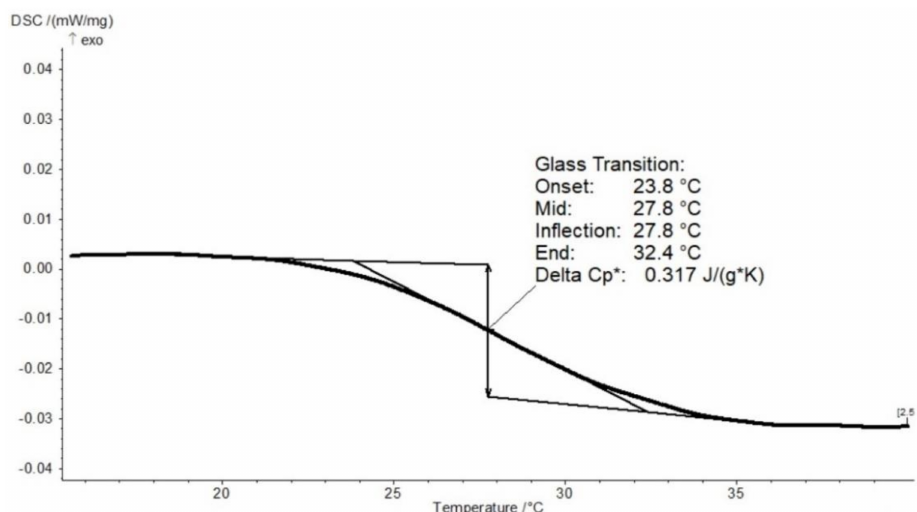
Figure 2. DSC profile of freeze dried pumpkin powder conditioned at a w = 0.0.